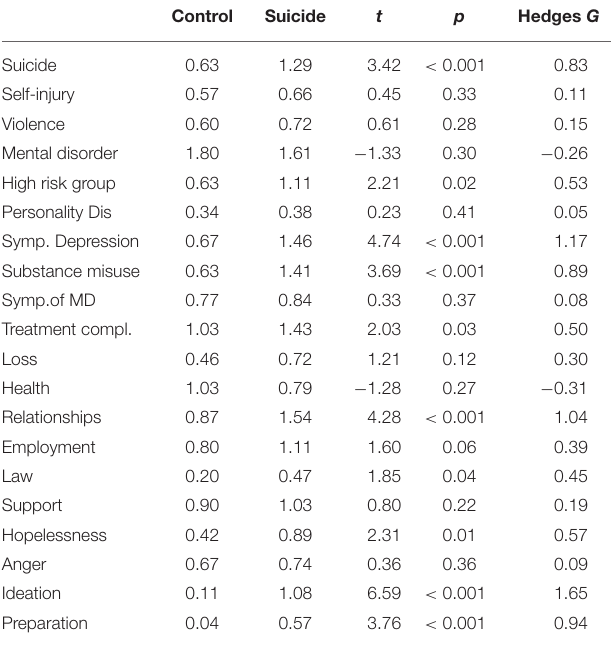
TABLE 3 | Mean RoSP scores and inferential statistics for the patients grouped into suicide vs. control for study 1.